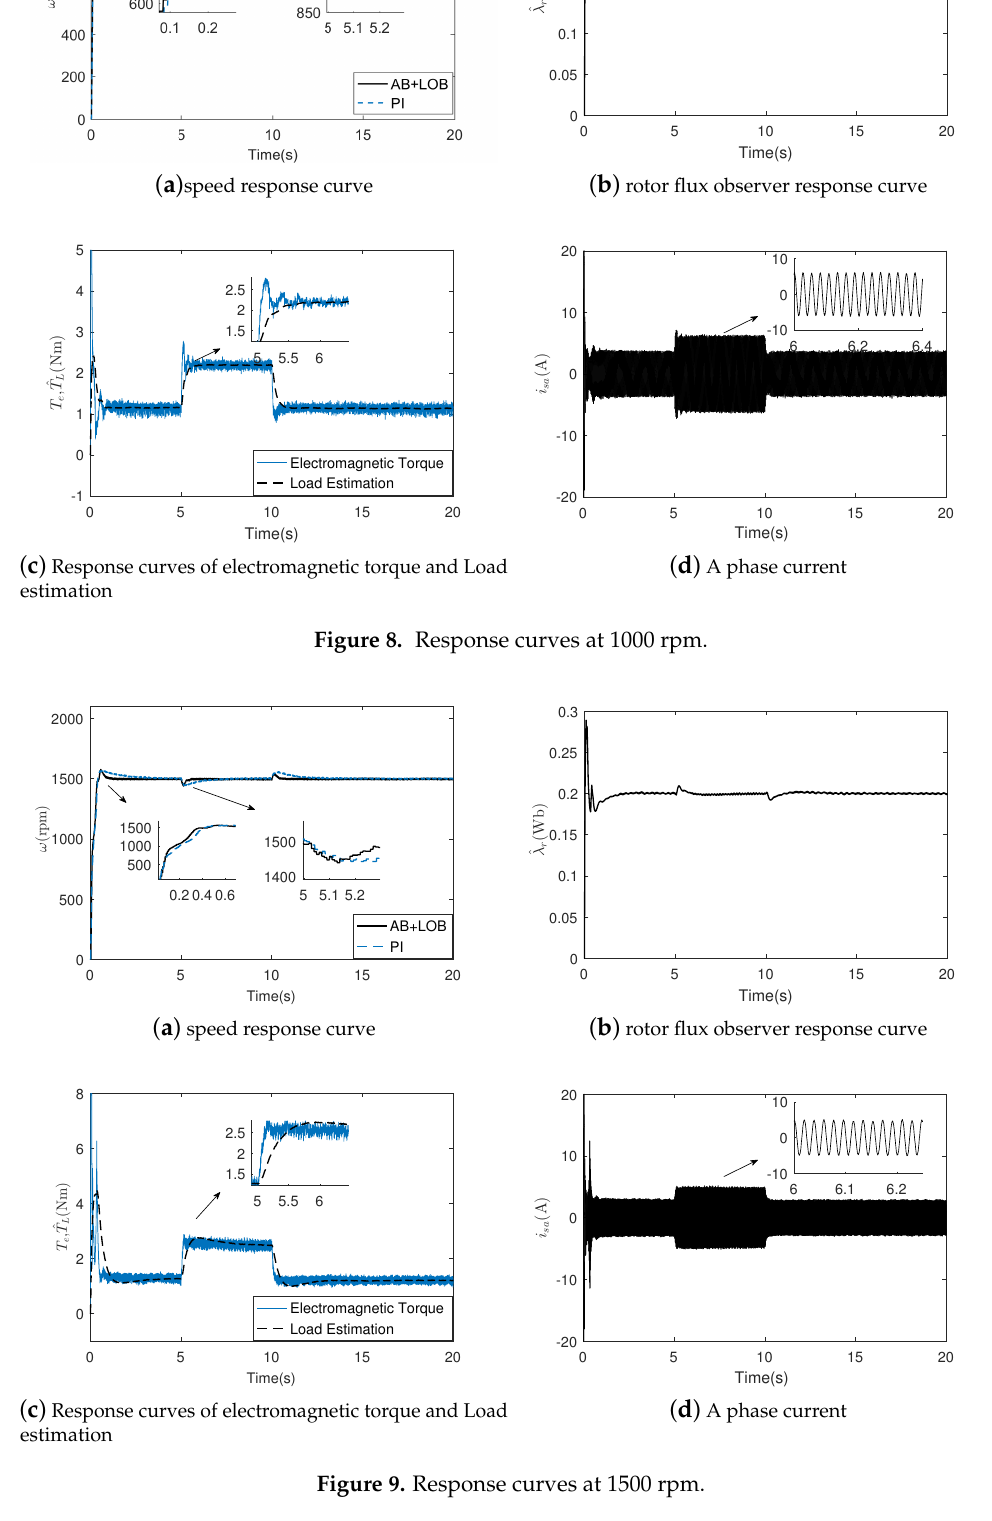
Figure 9. Response curves at 1500